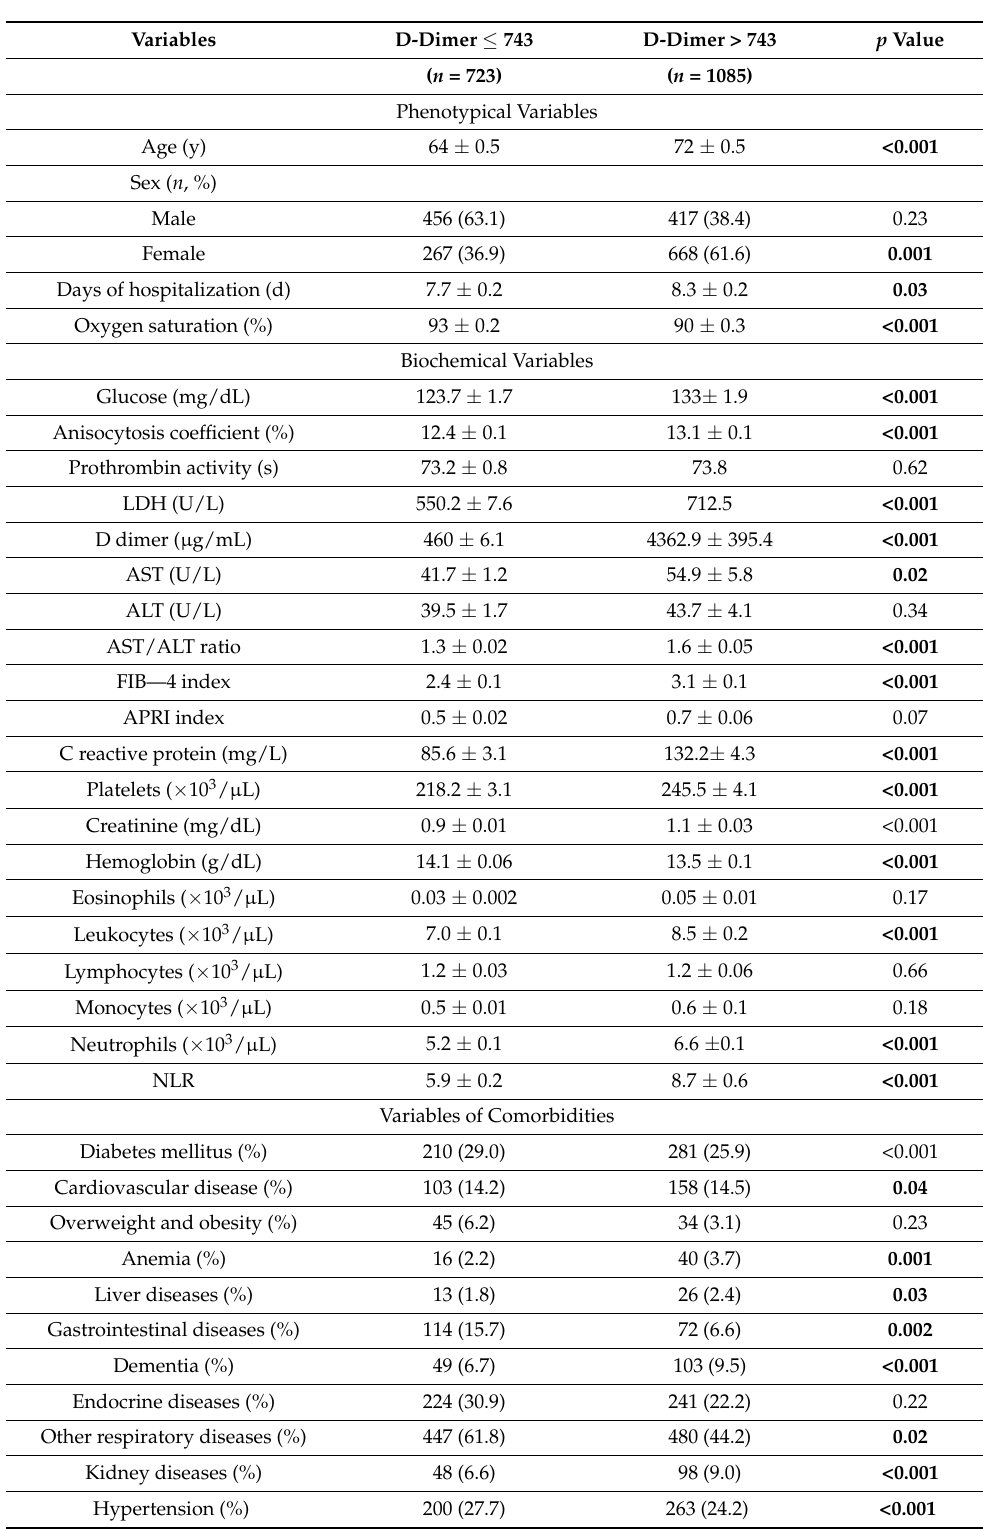
Table 3. Comparison of clinical and phenotypical variables of COVID-19 infected patients according to D-dimer